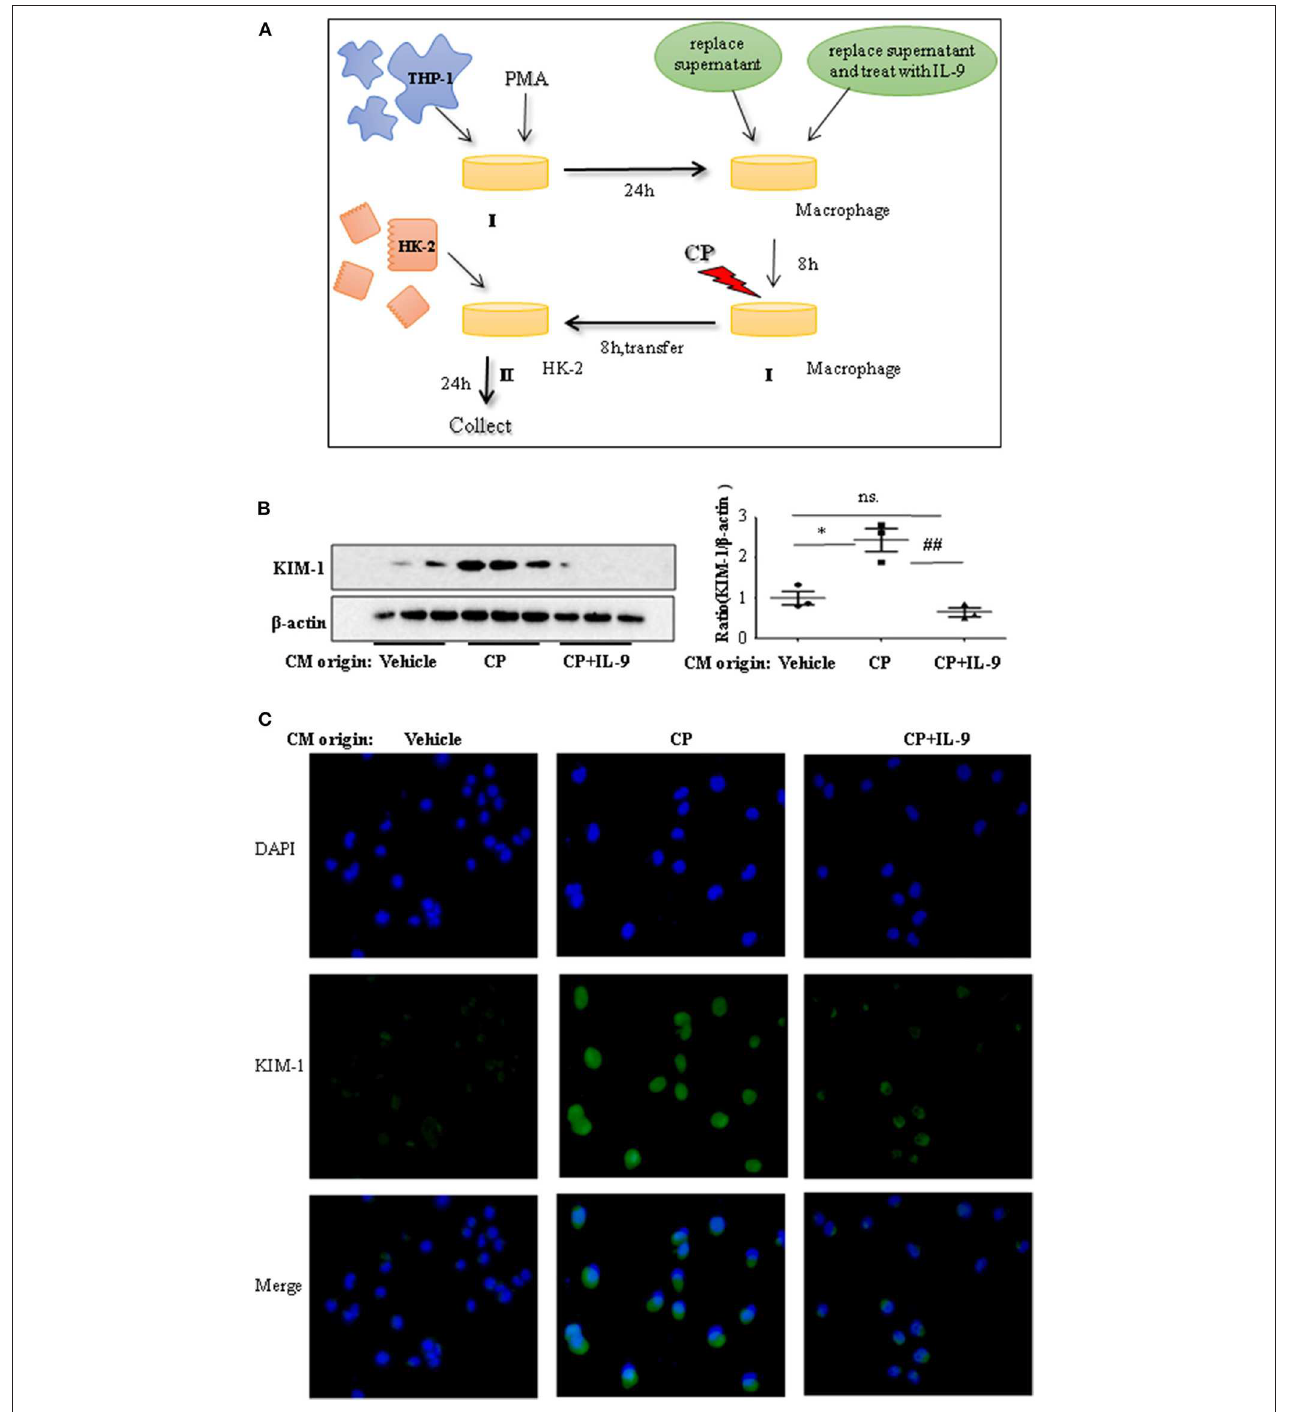
FIGURE 4 | Interleukin-9 (IL-9) suppressed the kidney injury molecule-1 (KIM-1) expression of renal tubular epithelial cells with THP-1 conditioned medium (CM). Data were represented as mean ± SD of three independent experiments. (A) The coculture was set up as follows: THP-1 cells were seeded in the presence of phorbol 12-myristate 13-acetate (PMA) (100 nmol/L) to let them differentiate into macrophages. After 24h, replace supernatant or replace supernatant and treat with IL-9 (100ng/ml) for 8h, then treat with cisplatin (CP) (100 µ mol/L). Eight hours later, transferred the supernatant to HK-2 cells. Collected the supernatant and cells (CM) for further test. (B) Western blot was performed in HK-2 cell lines incubated with CM to determine KIM-1 expressions. Each lane represents one sample from an individual mouse. Dot plots show the corresponding quantification of band intensity and fold change. Western blot analysis of KIM-1 expression in HK-2 cell lines incubated with CM, and data are represented as mean ± SD of three independent experiments. * P < 0.05 vs. the vehicle group; ## P < 0.01 vs. the CP-treated group. (C) Representative images of KIM-1 immunohistochemical staining in HK-2 cells with different CM.